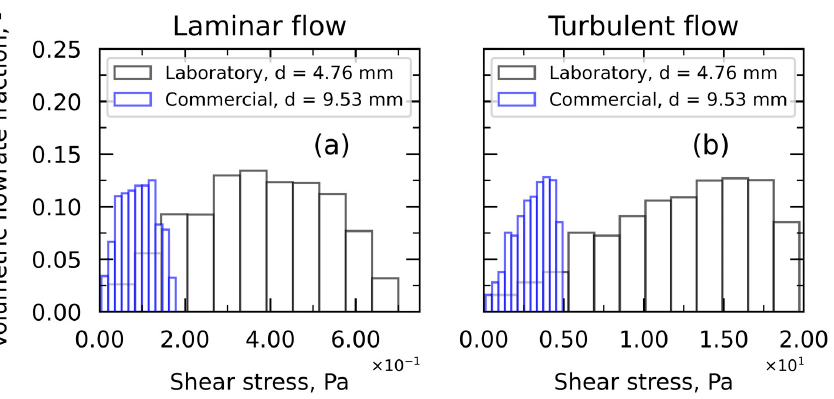
Figure 7. Shear stress distribution weighted on normalized volumetric flowrate for commercial (blue histogram) and laboratory (black histogram) unit following application of Approach 1 for laminar flow ( a ) and turbulent flow ( b ).